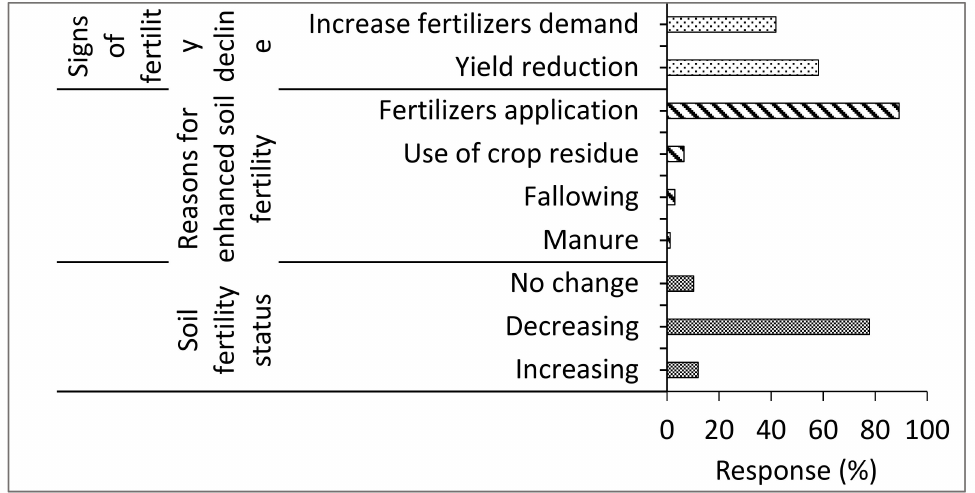
Figure 4. Soil fertility status as perceived by